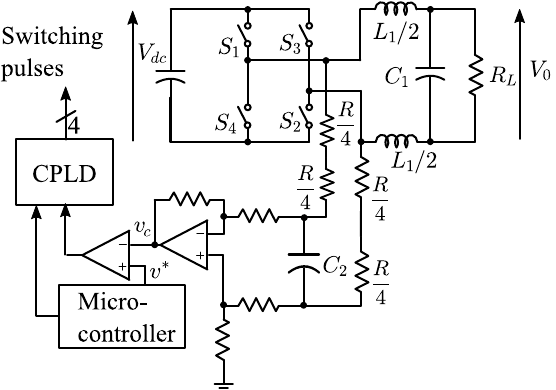
Figure 1. Schematic of voltage mode controller based single-phase full bridge voltage source inverter.